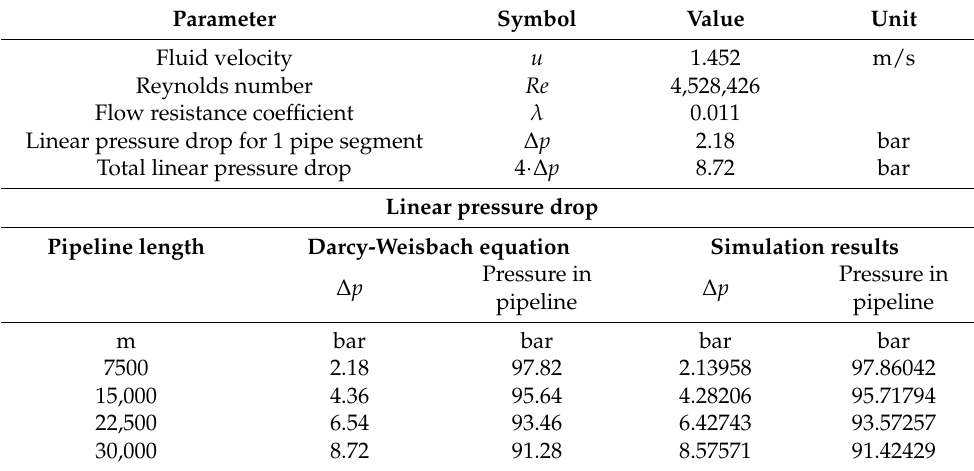
Table 7. Linear pressure drops for successive pipeline segments.